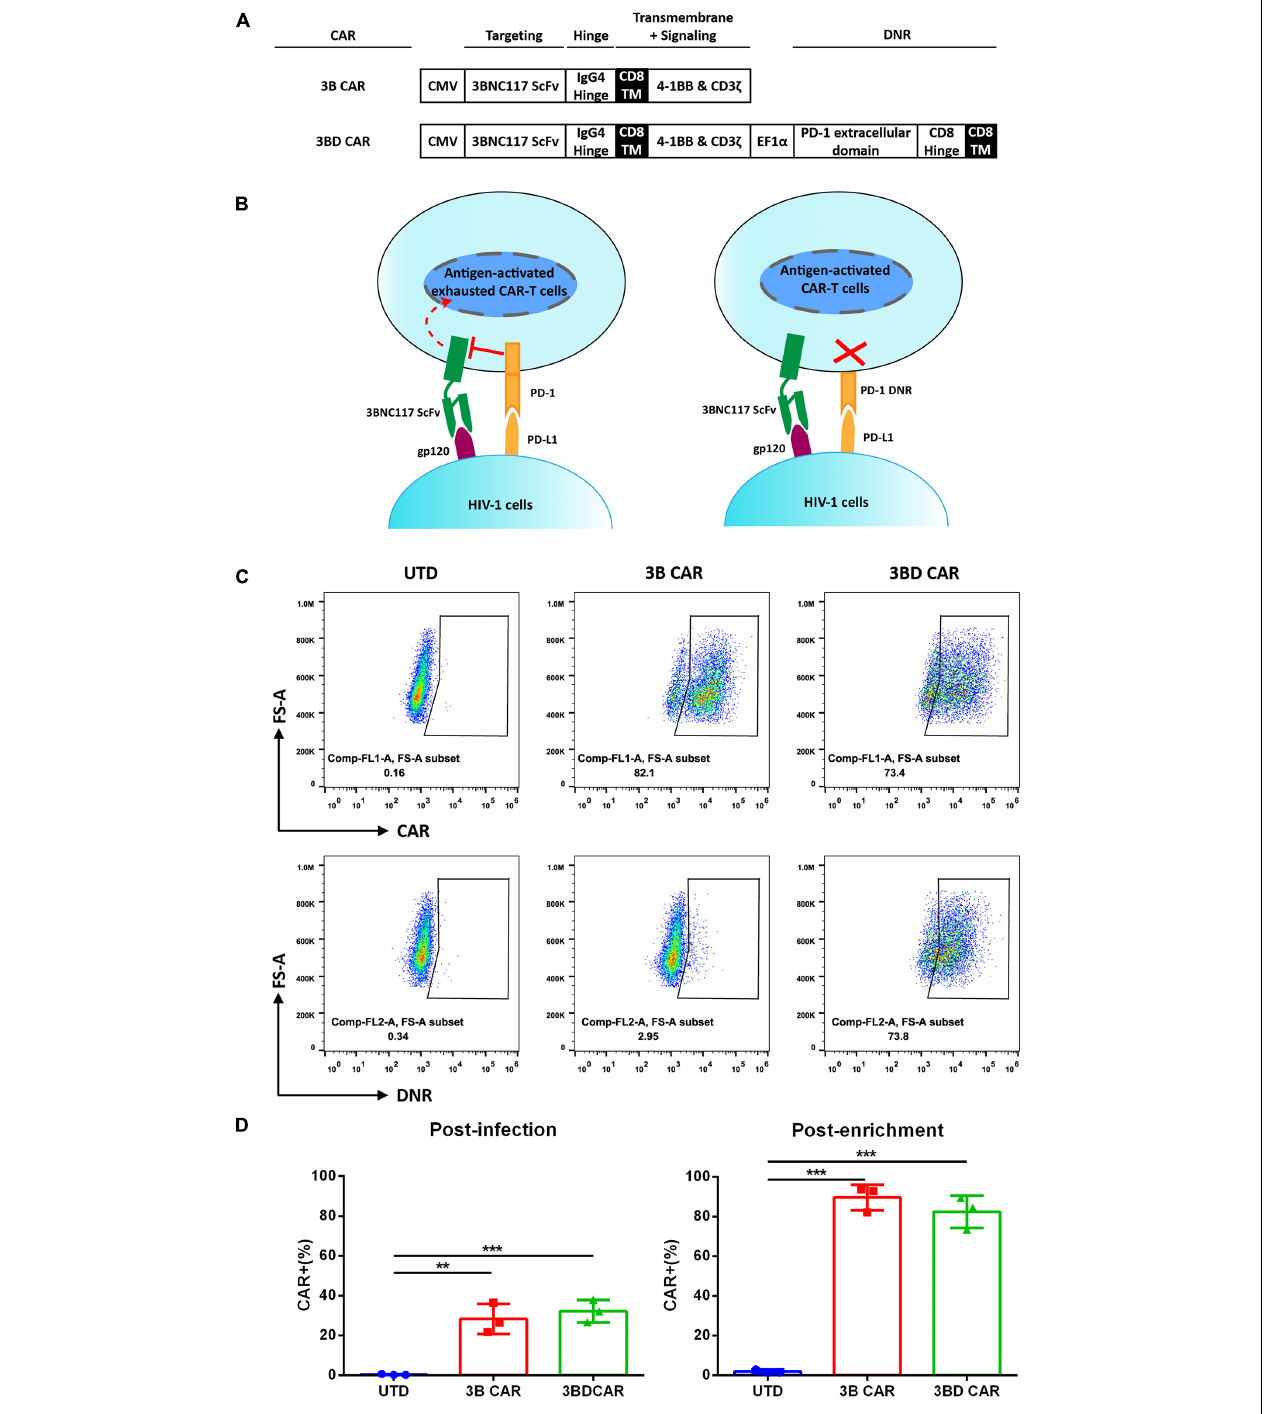
FIGURE 1 | Design and expression of 3BNC117-based CAR constructs. (A) Schematic diagram of the 3BNC117 CAR (3B CAR) and 3BNC117-DNR (3BD CAR) constructs. CMV and EF1 α indicated in the diagram are promoter sequences. (B) Schematic representations of antigen-activated T cells binding PD-L1 via the endogenous PD-1 receptor (transmitting a coinhibitory signal) or DNR lacking an inhibitory signaling domain. (C) Representative flow plot showing surface CAR and DNR expression on sorted CD3 + T cells by detecting human Fab and CD279 through flow cytometry. Untransduced CD3 + T cells (UTD) served as a negative control. (D) Percentage of CAR + human primary CD3 + cells 4 days after LV transduction (post-infection), and 5 days after enrichment by fluorescence-activated cell sorting (post-enrichment). The data show the mean ± SEM of n = 3 human cell donors. Statistical analysis was performed by one-way ANOVA followed by Tukey’s post-test analysis. ** P < 0.01, *** P <